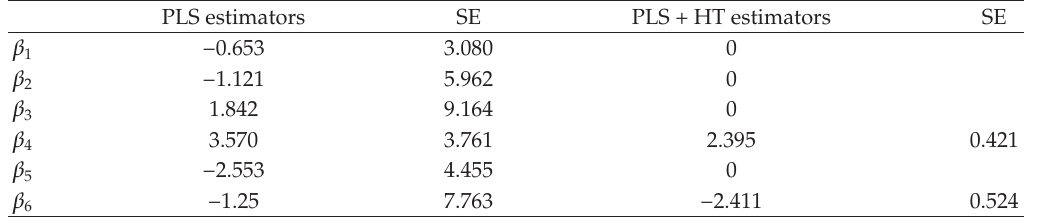
Table 10: Estimated Coe ffi cients for Model